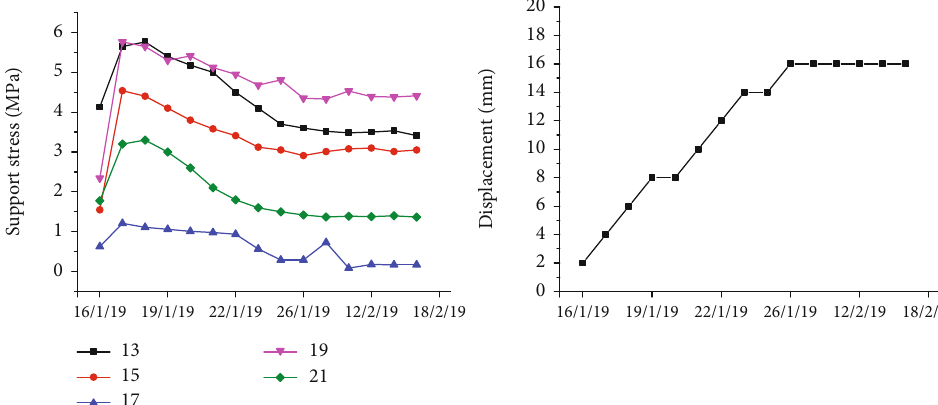
Figure 16: Analysis of monitoring results: support stress and displacement of Section II